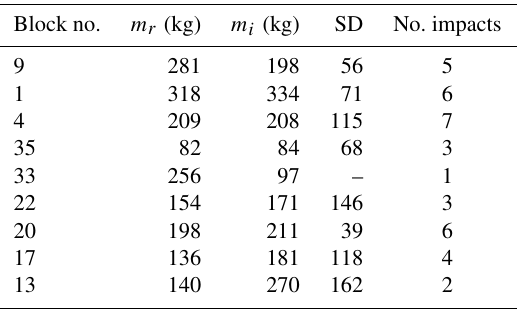
Table 2. Comparison between the real mass m r of the blocks and the average inferred masses m i computed with Eq. (7). Block no.